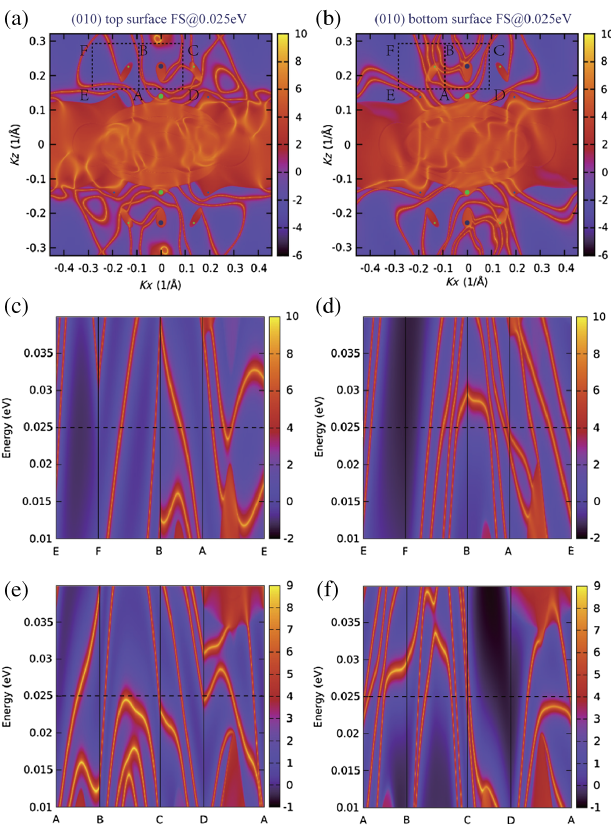
FIG. 10. Surface state of the first cleaved cell with surface potential energy of − 0 . 4 eV. (a,b) Fermi surface on the top and bottom (010) surfaces, respectively. The small dots represent the single projected WP, and the large dots represent two WPs with the same chirality projecting on top of each other. Panels (c) and (e) are the surface states of the top surface along the closed paths of E-F-B-A-E and A-B-C-D-A, respectively. Panels (d) and (f) are the same as (c) and (e) but for the bottom